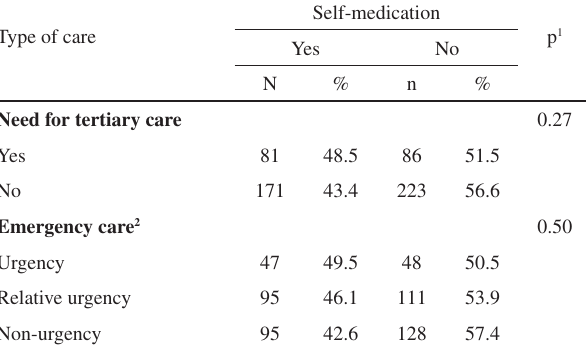
Table 6 - Use of self-medication to treat ocular conditions according to the need for tertiary and emergency care